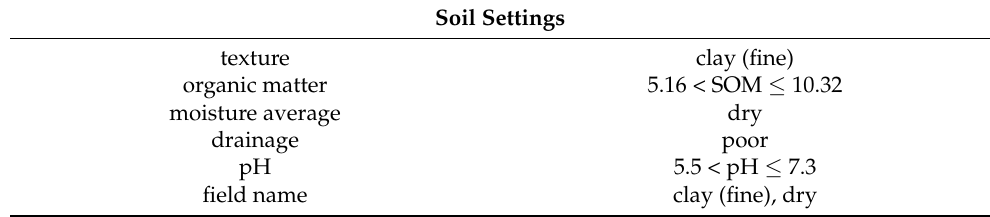
Table A2. The entries for the Cool Farm Tool as applied for the GHG emissions are as